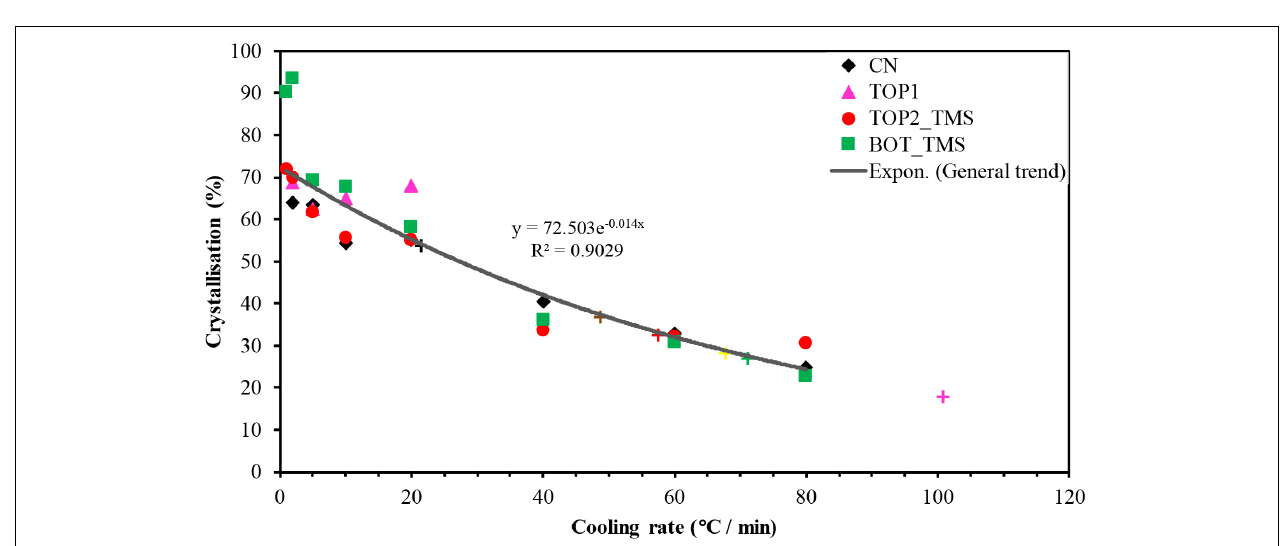
FIGURE 11 | Crystallization percentage with cooling rate for TGA-DSC values, obtained with both machines. The color of the symbols corresponds to the different samples. The triangles, circles, squares, and diamonds represent the individual experimental results, whereas the crosses are inferred natural cooling rates based on the measured crystallinity of samples (using CSD method and the general trend equation). Most of the samples in contact with tree show a higher cooling rate than CN not in contact with tree.